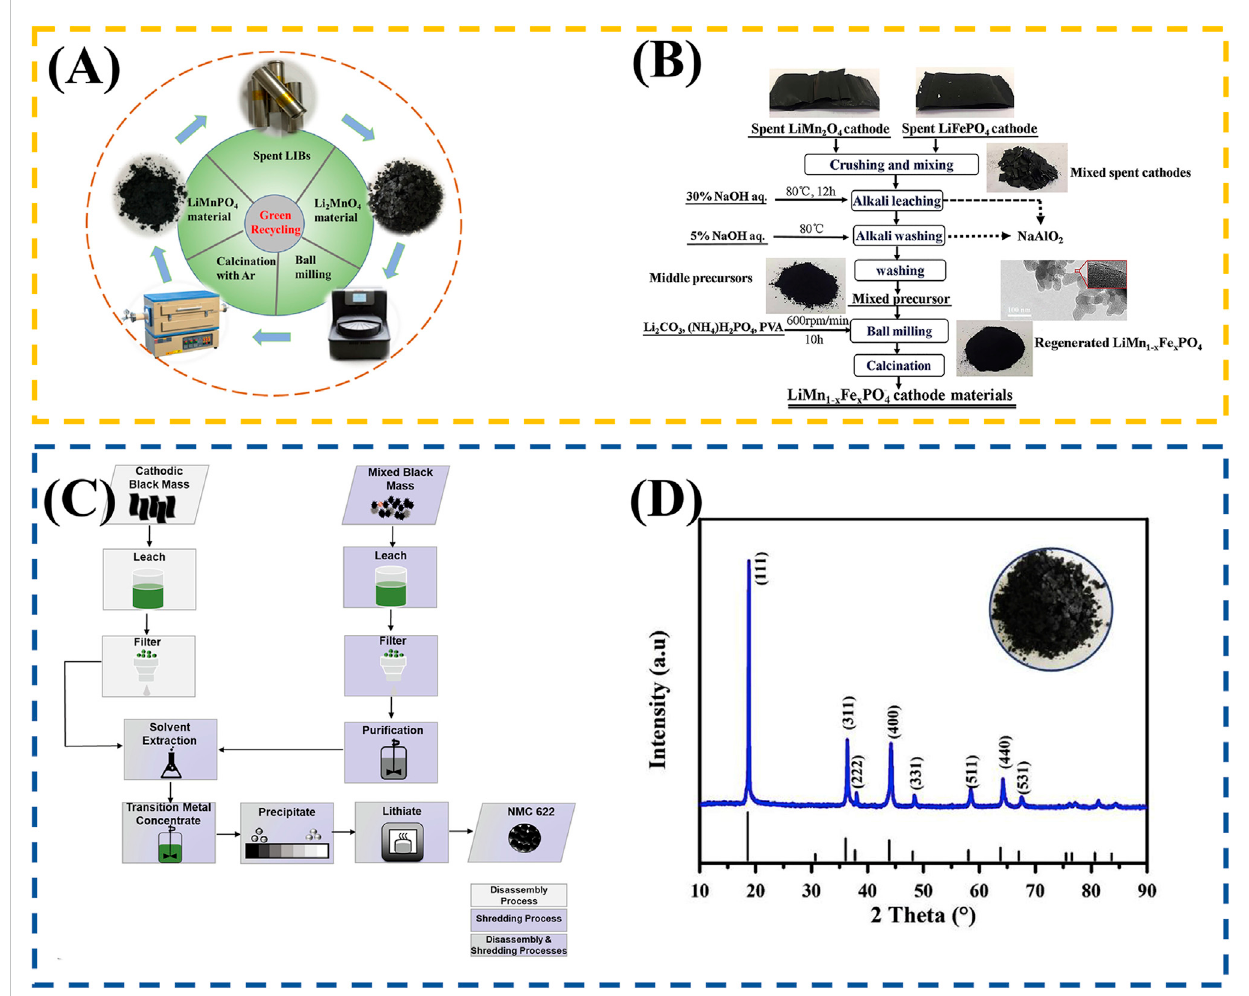
FIGURE 6 (A) Schematic of spent LMO and nano-LiMnPO 4 /C. (B) Schematic of the LMOand LFP recycling process; (C) Diagram of disassembly and shredding process applied for cathode black mass recovery; (D) XRD pro fi les of the spent LMO cathode